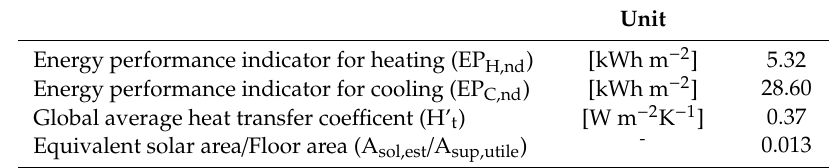
Table 3. Standard nZEBs energy assessment for the considered case